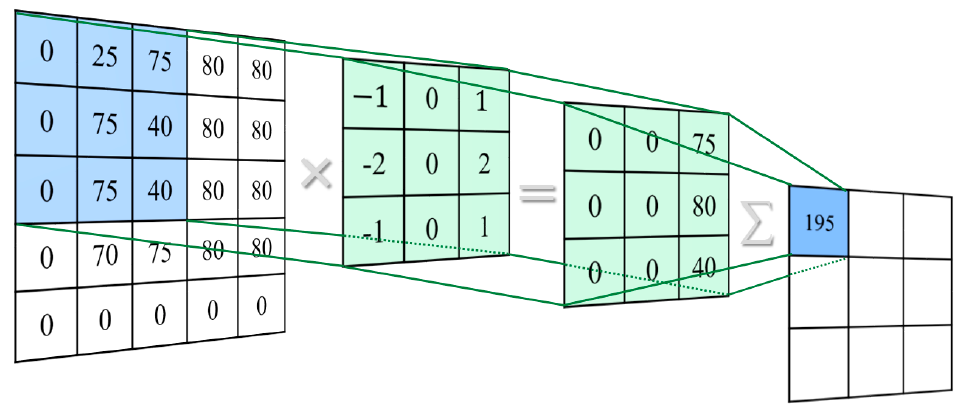
Figure 1. Schematic diagram of convolution in convolutional neural network (CNN) (the elements in the matrix represent the pixel values of the input data and weights).